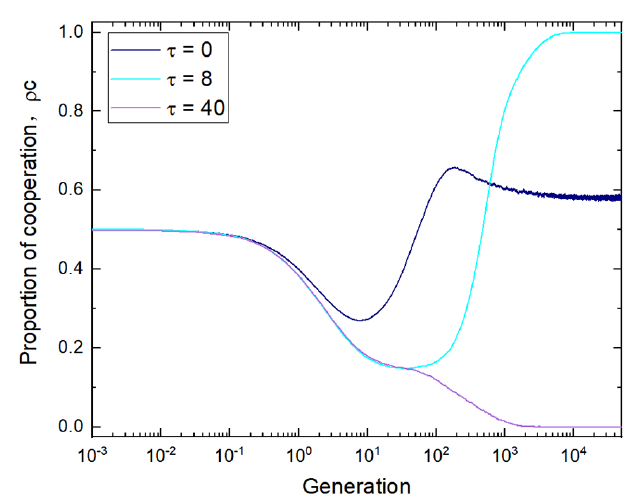
Figure 2. Time series of the proportion of cooperation, ρ c , at b = 1.04 and β = 0.5. Only the results obtained on the bottom network are shown here. Other parameters are exactly the same as those in Figure